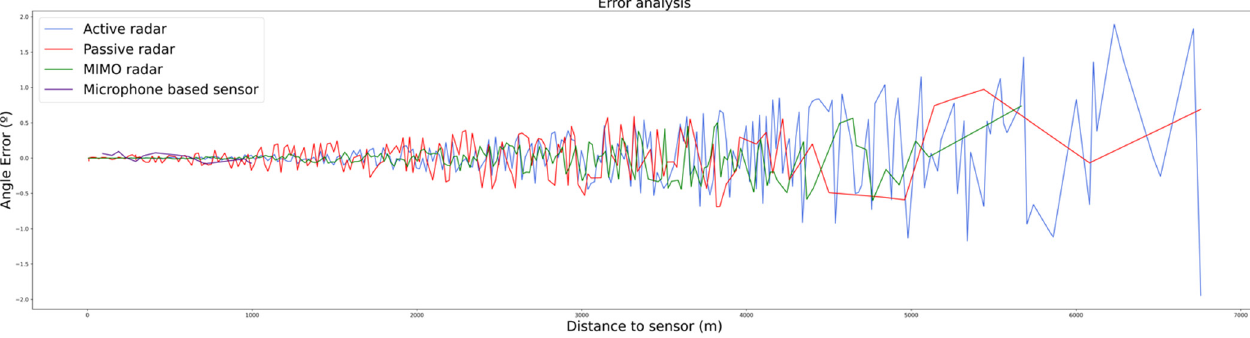
Figure 7. Angle error of each of the plots as distance to each of sensors’ receivers increases.